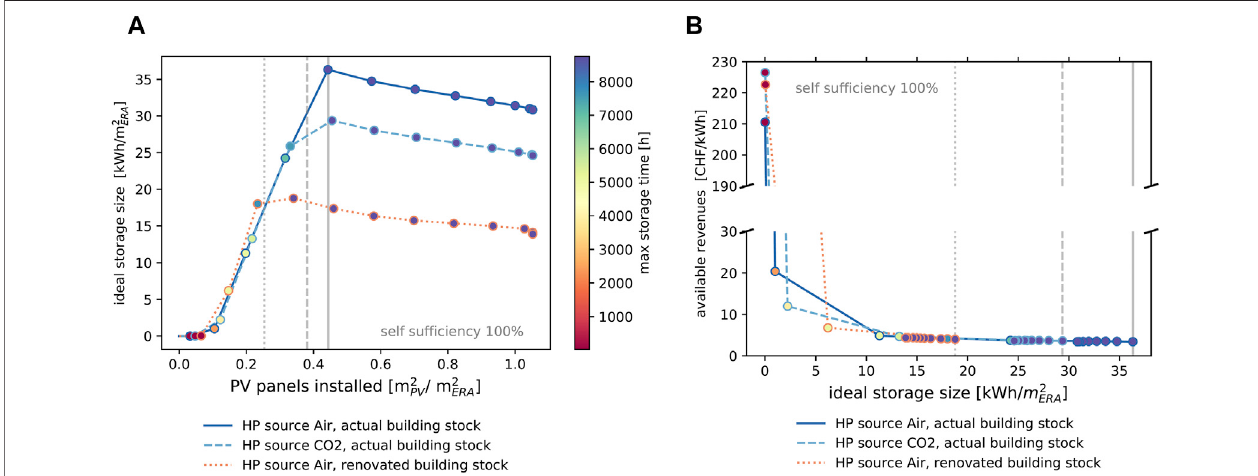
FIGURE 10 | Key identi fi ers of a required storage system with round-trip ef fi ciency η (cid:1) 100% (equivalent to Point S in Figure 9A ) to store surplus PV electricity for different ef fi ciency strategies. (A) Required storage size and time; (B) directly available price from buying at a feed-in tariff of 0.08 CHF/kWh and selling at for electricity price 0.20 CHF/kWh.